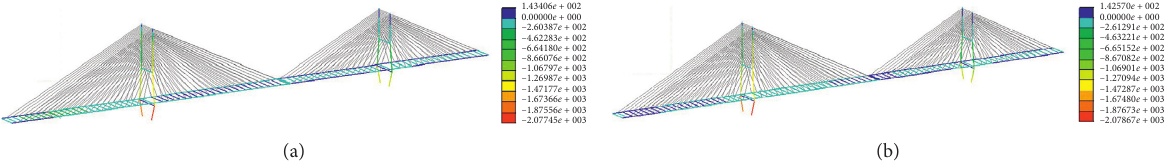
Figure 15: Stress distributions on pylons and the main girder for the emergency rescue cases (unit: tonf/m 2 ): (a) repair scheme 1 and (b) repair scheme 2.